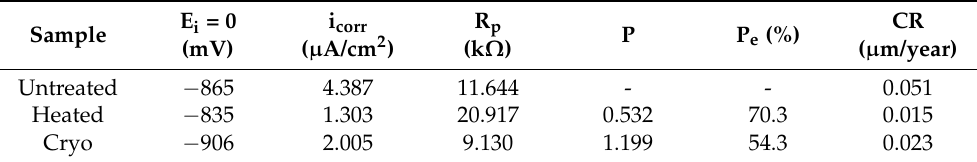
Table 1. Main corrosion parameters of untreated, heated and cryo specimens. E i =0: corrosion poten- tial; i corr : corrosion current density; R p : polarization resistance; P: porosity; P e : protective efficiency; CR: corrosion rate.